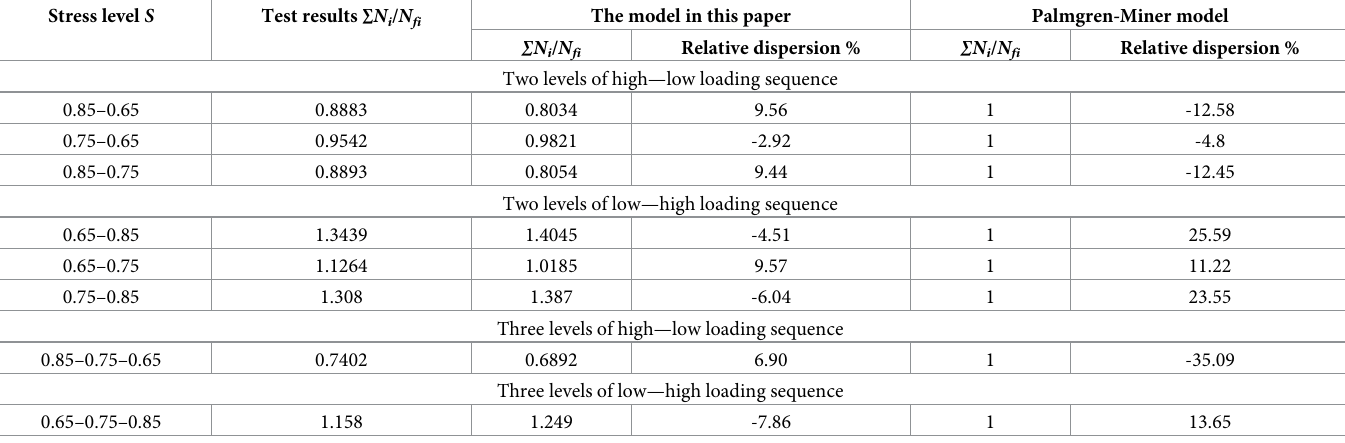
Table 17. Calculation and verification of fatigue cumulative damage